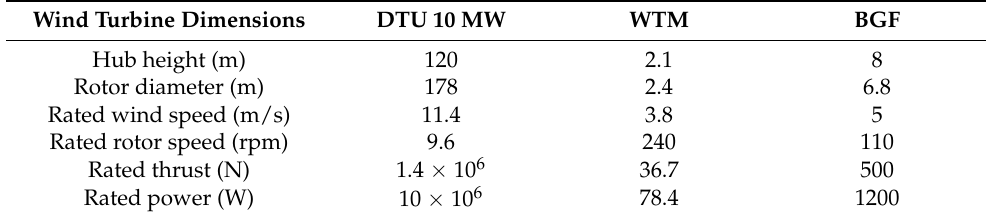
Table 4. Actual gross properties of the DTU 10 MW, wind tunnel model (WTM) and Blue Growth Farm (BGF)